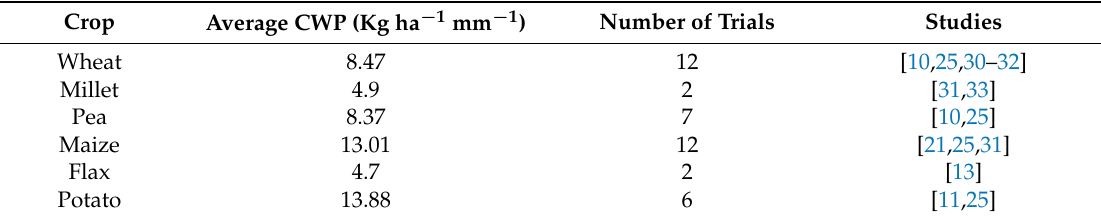
Table 2. Average CWP values for crops from selected with number of replications based on the following